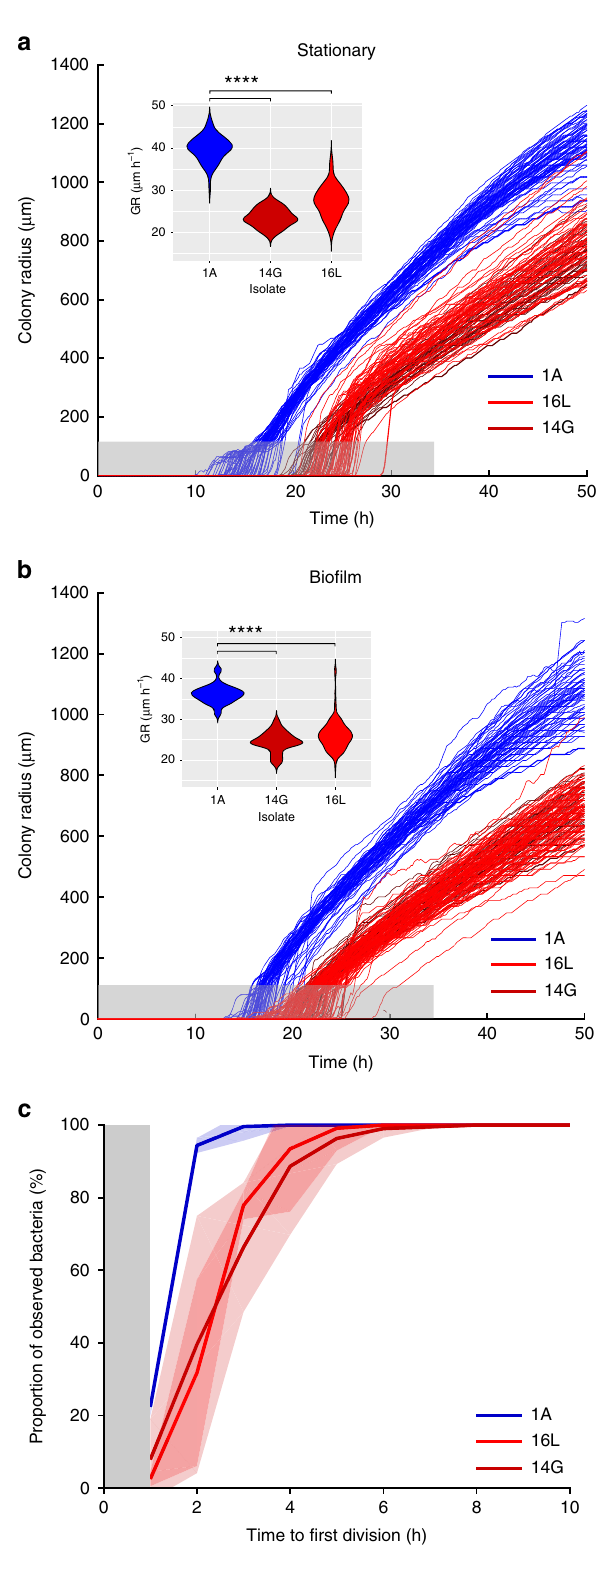
The increased bio fi lm formation by the isolates obtained later during the infection (group II) could have been due to a frame- shift mutation in the response regulator ArlR. Previous studies showed that disruption of arlSR increased bio fi lm formation in S. aureus 34,35 . Contradictorily, reduction in bio fi lm formation was